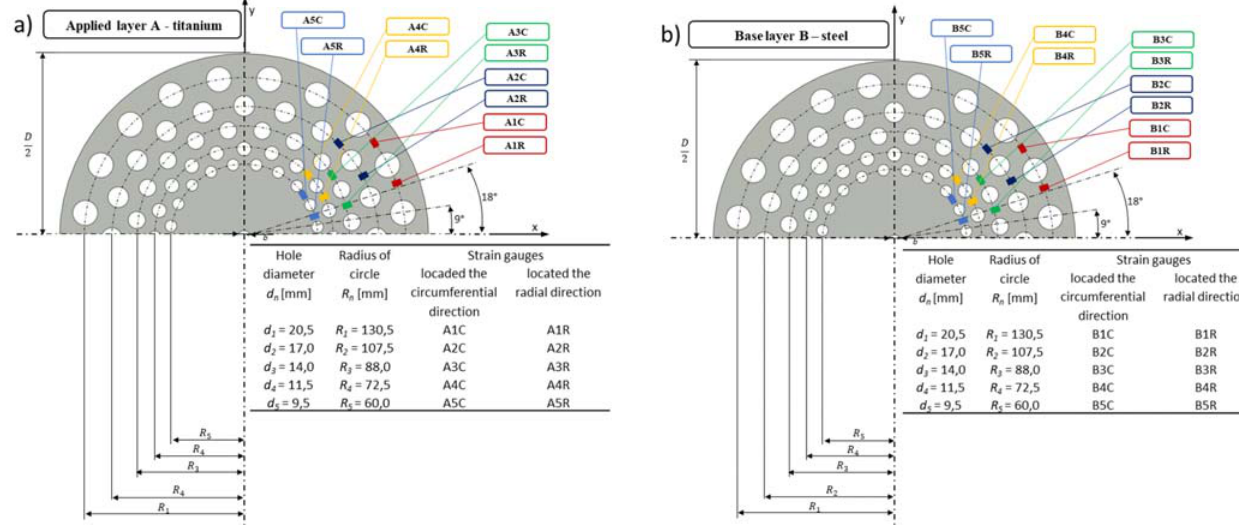
Figure 4: Arrangement of strain gauges on a bimetallic circular perforated plate: a) on the applied layer A – titanium; b) on the base layer B – steel